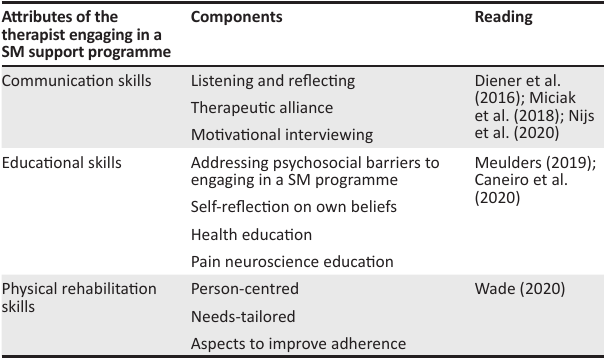
TABLE 1: Attributes of therapists supporting patients with musculoskeletal pain disorders towards SM. Attributes of the therapist engaging in a SM support programme